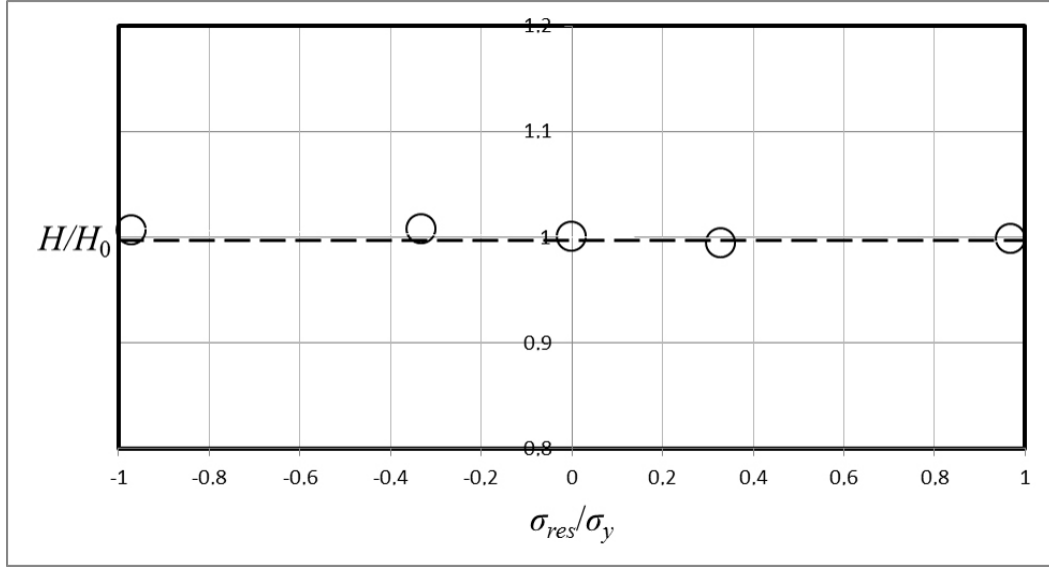
Figure 6 Figure 6. Nondimensionalized hardness, H/H 0 , as a function of the nondimensionalized equi-biaxial residual stress field, σ re s / σ y , at Vickers indentation. The results are pertinent to σ y = 400 MPa. (- - -), H / H 0 = 1. (o), numerical results for different values on σ re s / σ y